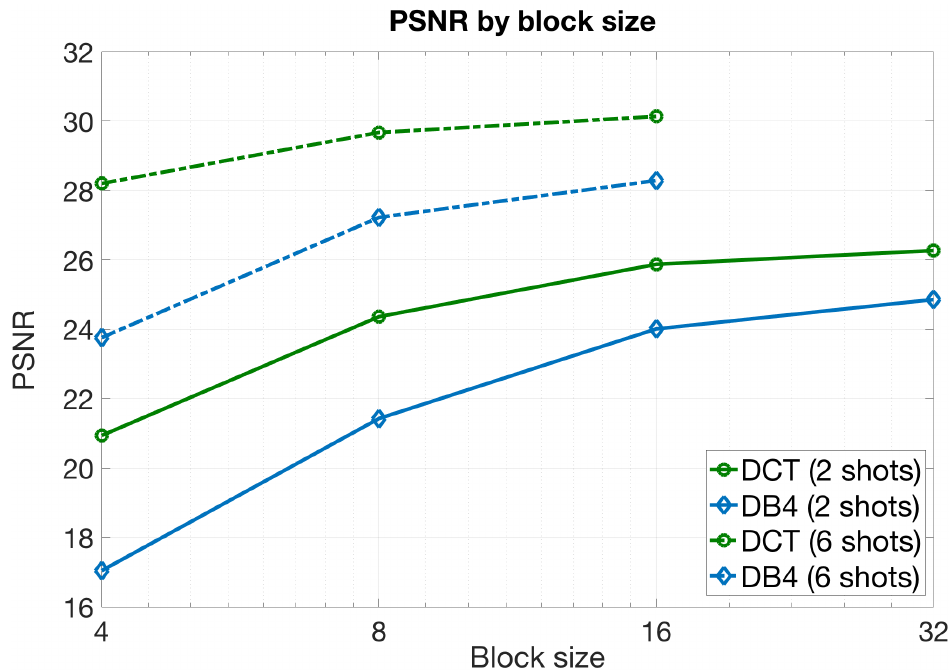
Figure 8. PSNR values by considering 2 and 6 shots, with different block sizes and using the DCT and DB4